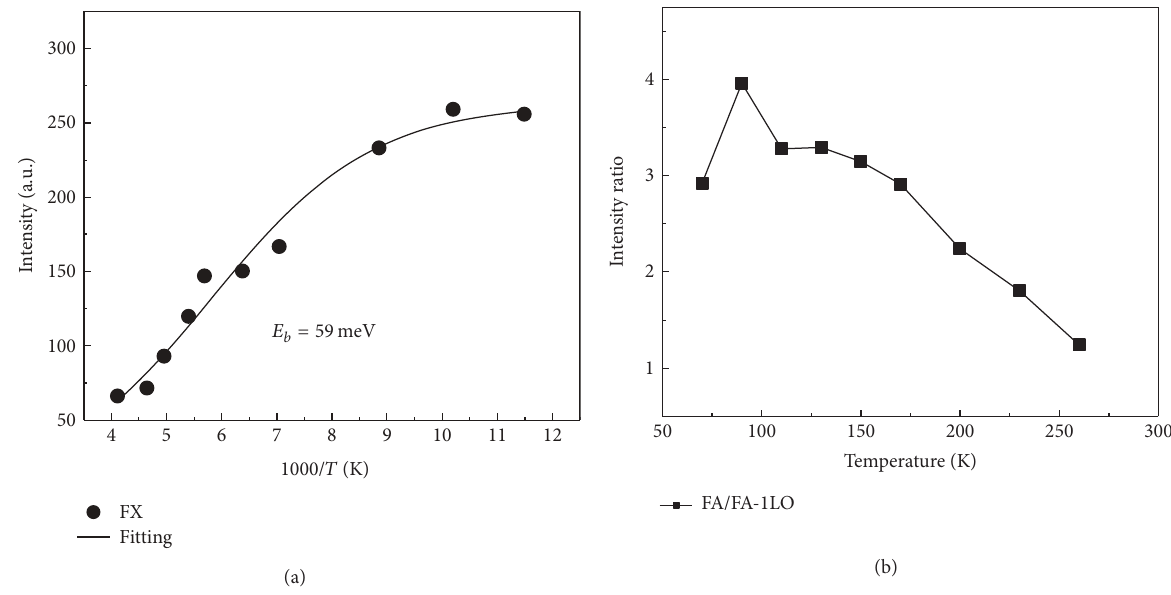
F 5: (a) e integrated intensity of the FX emission as a function of the temperature for sample A. e solid lines are the curves �tted of FA emission to FA-LO emission at various temperatures for sample A. by formula (1). (b) e intensity ratio 𝐼𝐼 0